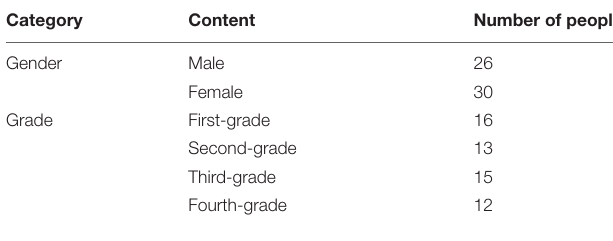
TABLE 2 | Basic situation of